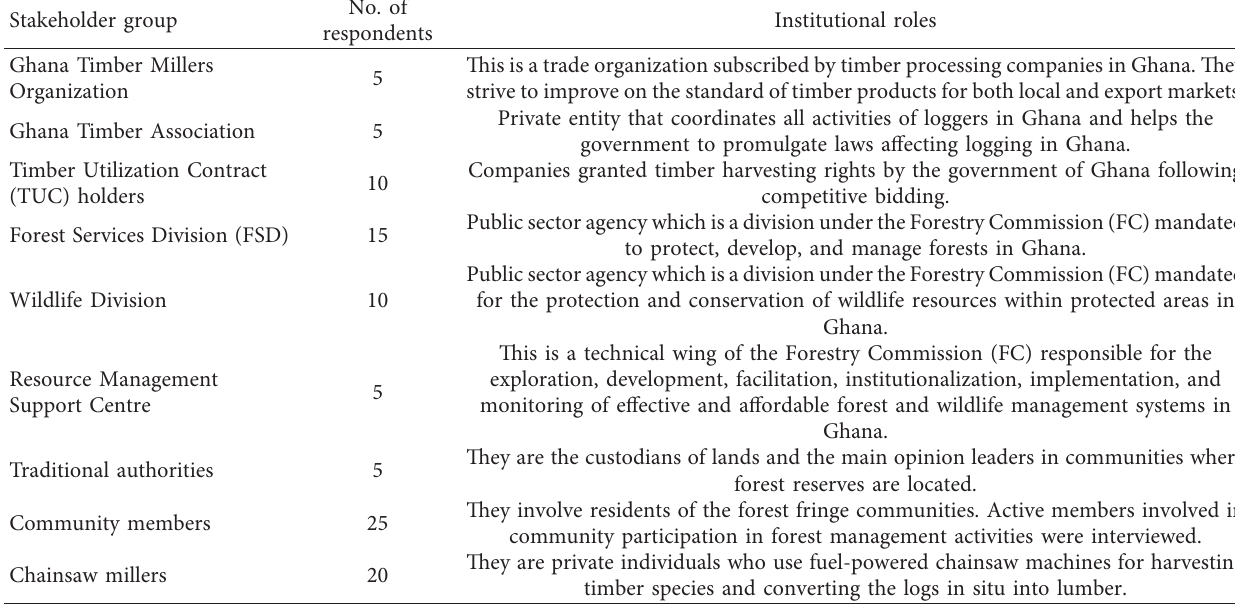
Table 2: Category of respondents and the roles their institutions play in forest management and utilization. Stakeholder